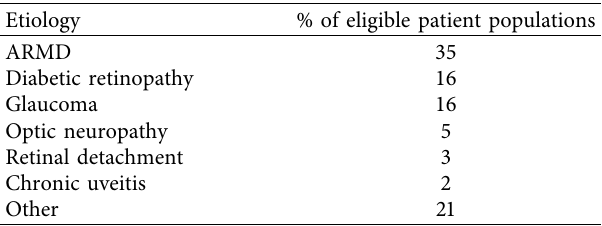
Table 1: Etiology of low vision for eligible patients ( n �